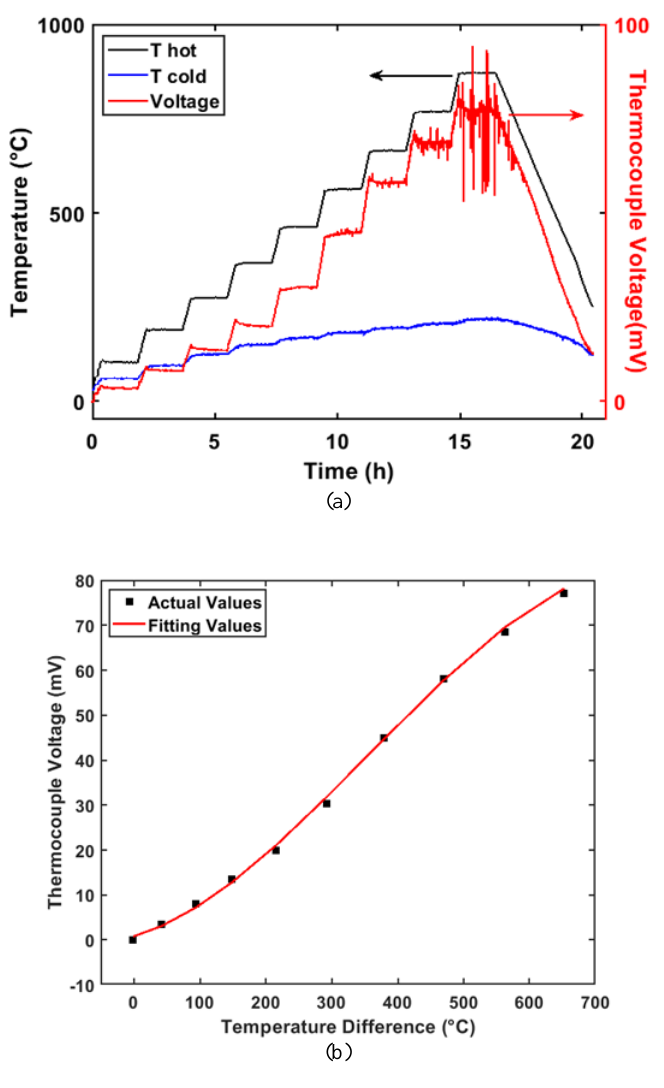
Figure 7. ( a ) Thermoelectric output of the In 2 O 3 :ITO 90:10 thin-film thermocouple probe. The peak temperature of the hot junction was 871.26 °C. ( b ) Fitted static characteristic curve. The average Seebeck coe ffi cient was 124.50 µ V /